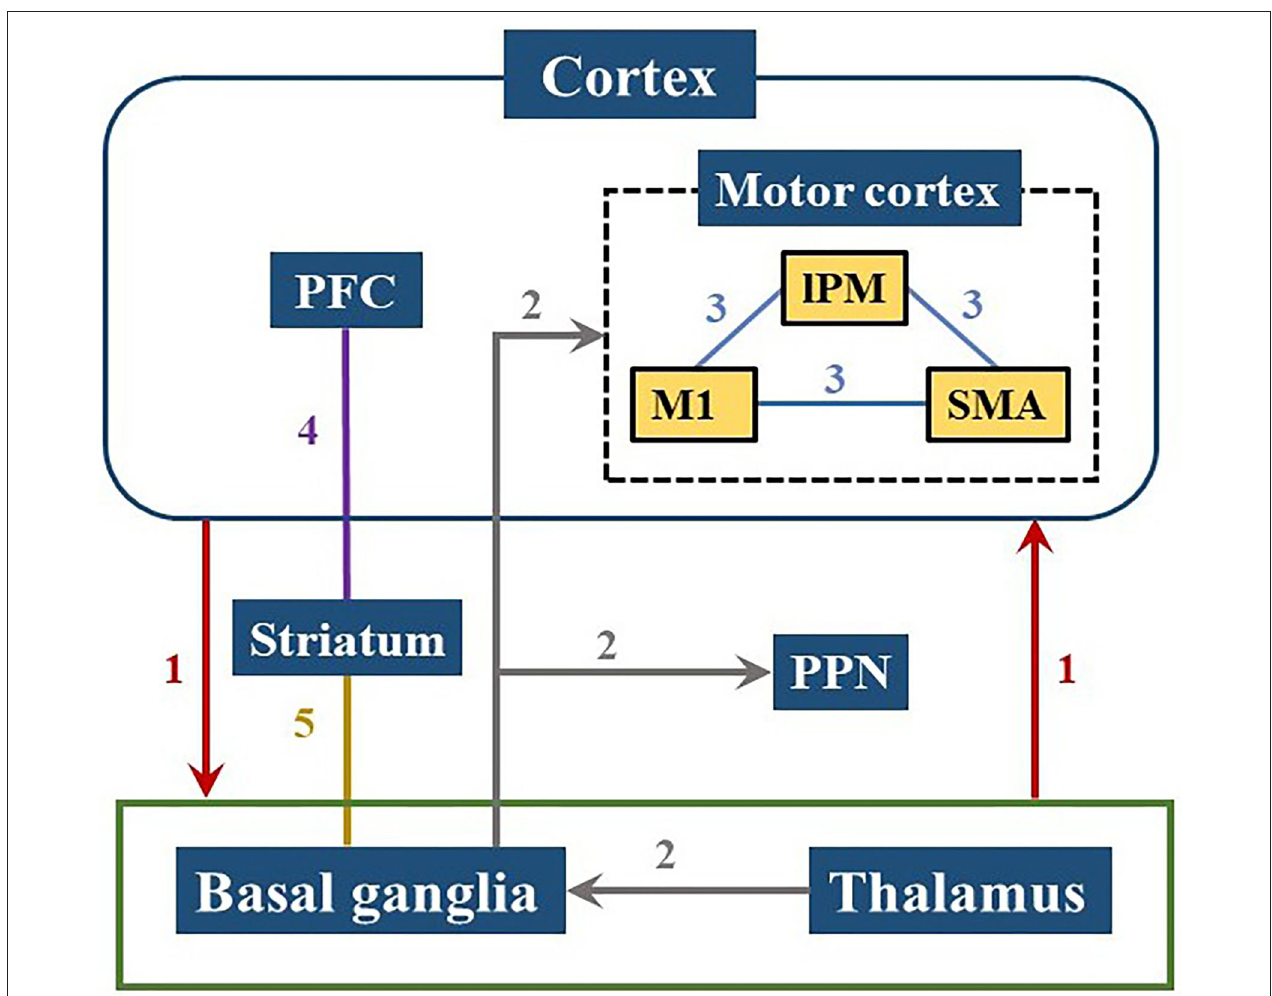
FIGURE 5 | Brain pathways involved in PD cognitive and motor dysfunctions. Neural information is transmitted from the cerebral cortex to the basal ganglia or thalamus and back to the cortex as shown in path 1. Path 2 demonstrates that the input from the thalamus in the basal ganglia is projected to the motor cortex or PPN, reflecting the pathological activities within the ganglia which can affect motor control process. The internal connection of the motor cortex in path 3 has a great influence on motor functions of PD patients. Path 4 and 5 are related to the striatum showing that the frontostriatal circuit and the basal ganglia-striatal circuit are both damaged in PD patients. PFC, prefrontal cortex; lPM, lateral premotor cortex; M1, primary motor cortex; SMA, supplementary motor area; PPN, pedunculopontine